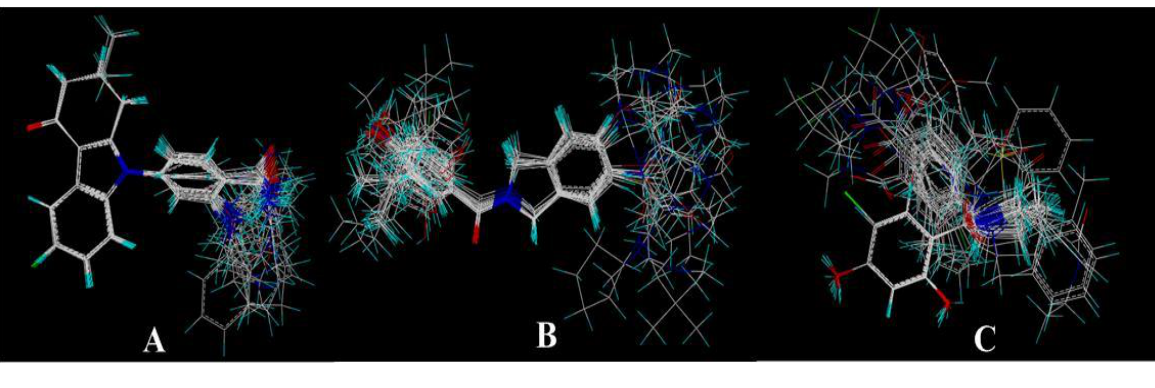
Figure 3. Receptor-based alignment. ( A ) Compound 17 was selected as a template for alignment; ( B ) Compound 24 was used as a template for alignment; ( C ) Compound 19 was employed as a template for alignment. Alignment of these compounds was further used for 3D-QSAR model